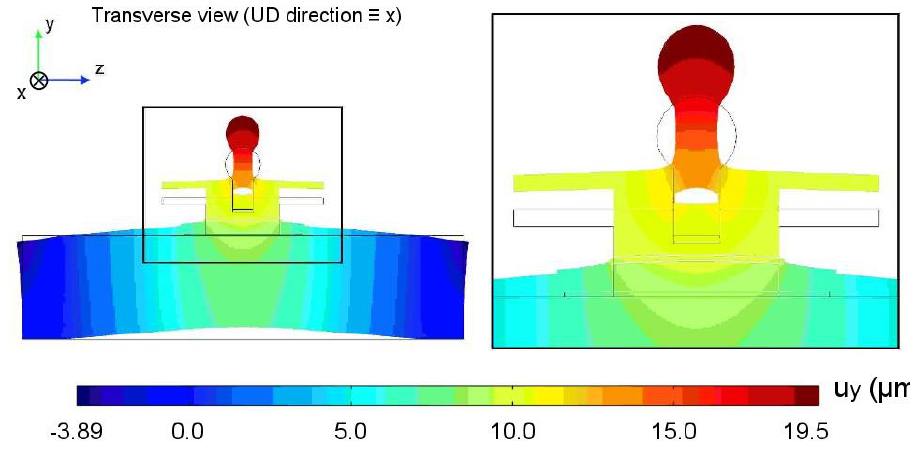
Figure 7. Normal displacement for a standard simulation with an applied pull-off load of 10 kN.